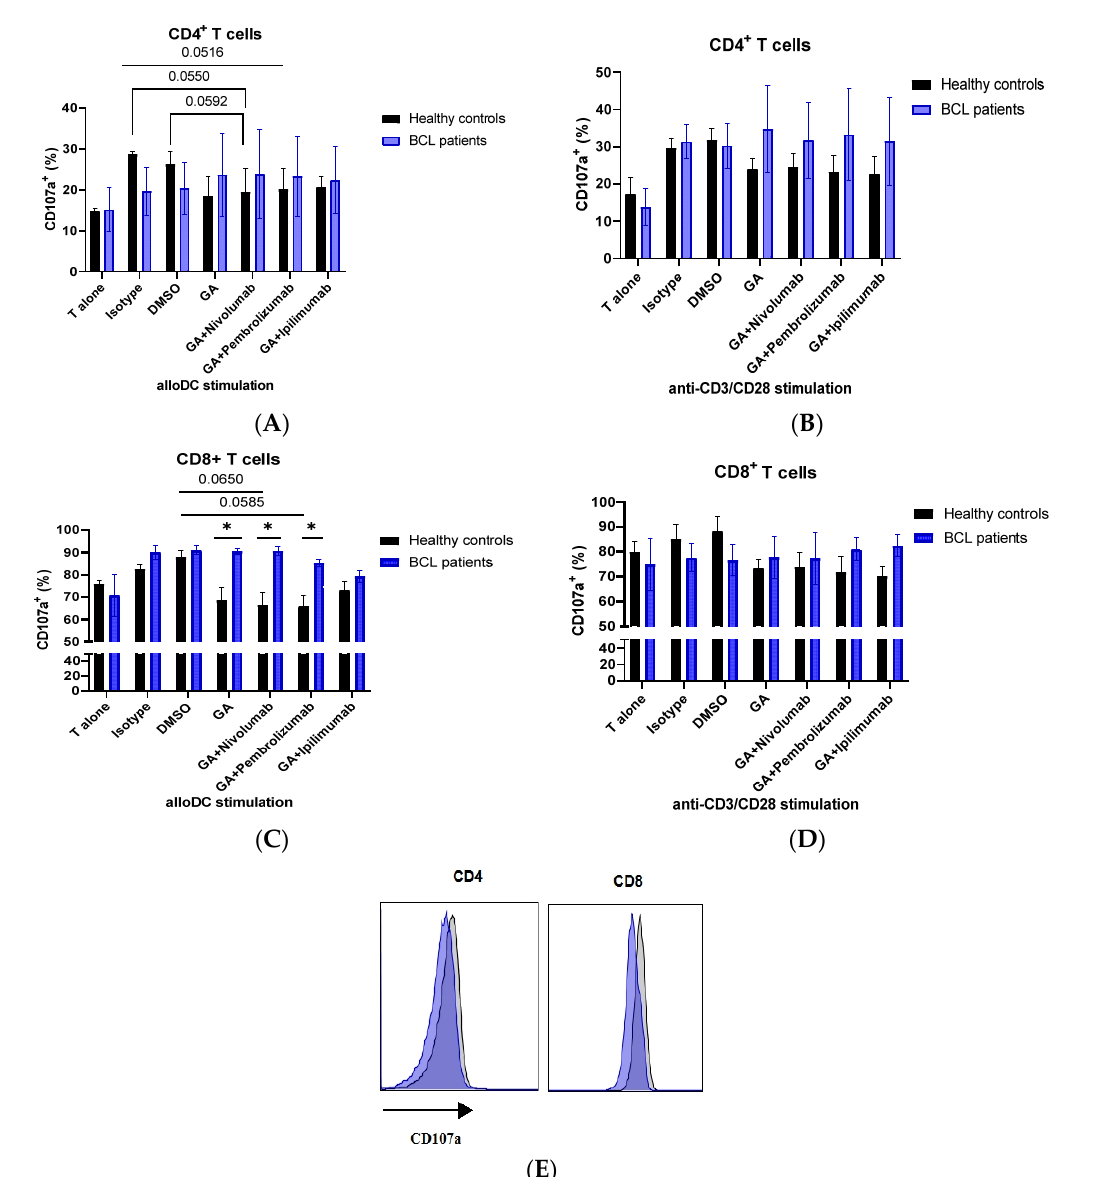
Figure 2. HSP90 inhibition downregulates CD4 and CD8 surface expression. HSP90 inhibitor downregulates surface expression of CD4 ( A ) and CD8 ( B ). T cells were incubated for 4 days with allogeneic mo-DCs in the presence or absence of 0.1 µM geldanamycin (GA). ( C ) Representative flow cytometry plots showing downregulation of CD4 and CD8 molecules on the surface of T cells in response to GA in MLR. Data are presented as mean ± SEM. * p <0.05, ** p < 0.01.